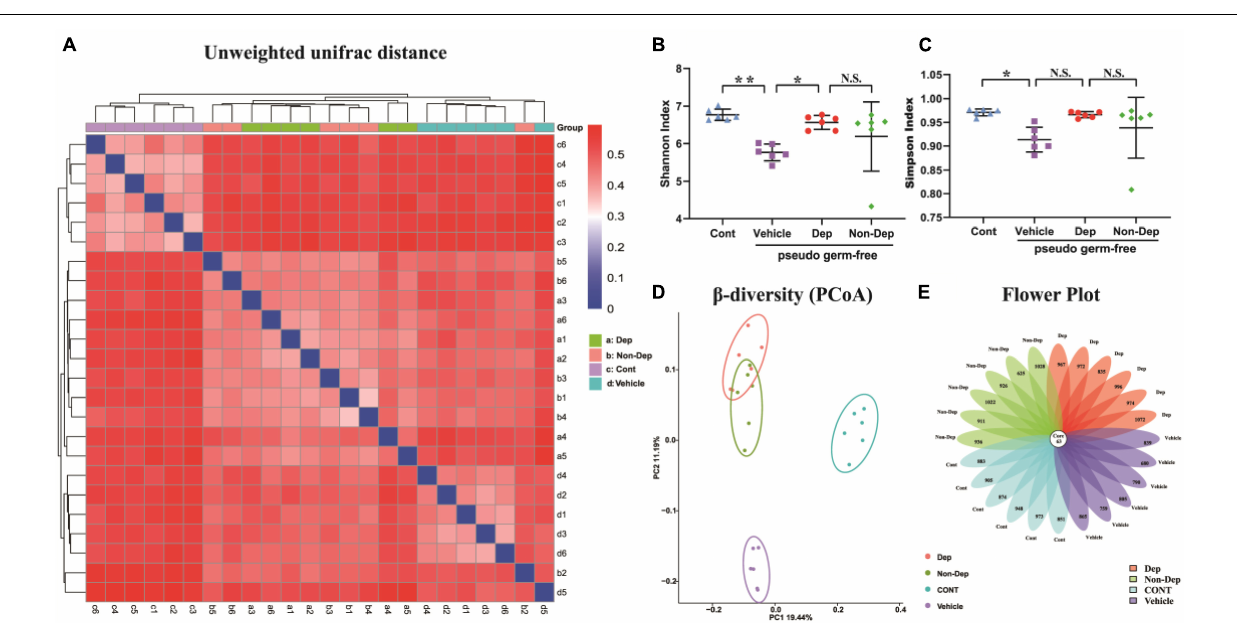
FIGURE 9 | Differences in gut microbiota profiles among Cont, Vehicle, Dep, and Non-Dep rats. (A) Unweighted unifrac diversity distance. (B) Shannon index (one-way ANOVA; F3, 20 = 4.901, p < 0.05). (C) Simpson index (one-way ANOVA; F3, 20 = 3.503, p < 0.05). (D) PCoA analysis of gut microbiota. (E) Flower plot of OTUs distribution. The numbers in the core represent the OTUs shared by all samples, and the numbers on the petals represent the total OTUs of each sample minus the number of OTUs shared. The α -diversity is shown as mean ± SEM. ( n = 6). * p < 0.05, ** p < 0.01; N.S., not significant. Cont, control; Dep, depression-like behavior; Non-Dep, non-depression-like behavior; PCoA, principal coordinates